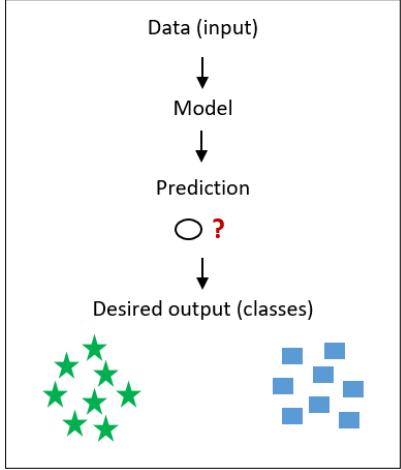
Figure 5. Visualization of supervised machine learning